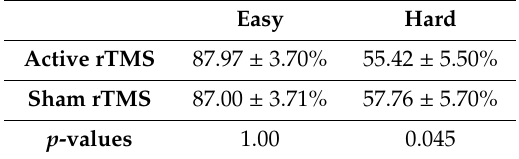
Table 2. Average accuracy for the di ffi culty levels and the stimulation